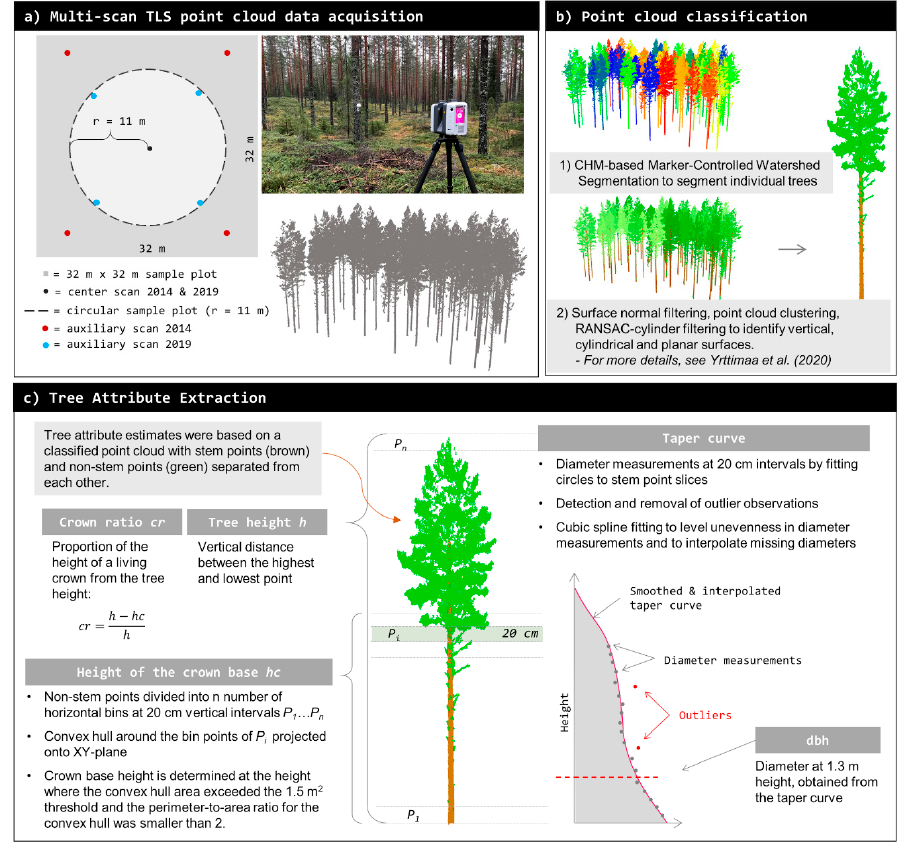
Figure 1. Outline of the terrestrial laser scanning (TLS) data processing workflow. ( a ) One center scan and four auxiliary scans were used to acquire a multi-scan TLS point cloud data in 2014 and 2019. ( b ) TLS-based canopy height model (CHM) and a Marker-Controlled Watershed Segmentation procedure was applied to normalized TLS point clouds to detect individual trees. Surface normal filtering, point cloud clustering, and Random Sample Consensus (RANSAC)-based cylinder filtering were applied to identify vertical, cylindrical, and planar surfaces to classify TLS point cloud into stem and non-stem points (for more details, see [39]). ( c ) Then, the classified point cloud was used to extract tree attributes, namely diameter-at-breast-height (dbh) and tree height (h) for all the trees, and height of the crown base (hc) and crown ratio (cr) for Scots pine ( Pinus sylvestris L.) trees. Tree attributes, namely dbh, g, h, d-h-ratio, hc, and cr were extracted from the classified point cloud (see Figure 1, Table 2). Dbh and h were measured following the procedure originally presented in [10]. In other words, h was determined as the vertical distance between the highest and lowest points for each tree. Stem taper curve was estimated to determine dbh by measuring diameters through circle fitting at 20-cm vertical intervals to the stem points. The outliers in diameter-height- observations were filtered out by comparing the measured diameters to the mean of three previous (or three closest at the bottom of the stem) diameters. Then a cubic spline curve was fitted to the diameter-height-observations to level unevenness in diameter measurements and to interpolate the missing diameters as suggested in [42]. Dbh was then obtained as the diameter at 1.3 m height from the taper curve. Tree-level g was computed from dbh measurements by considering the stem cross section as a circle (g = π ∗ dbh 2 /4) and d-h-ratio was computed as a ratio between dbh and h (d-h-